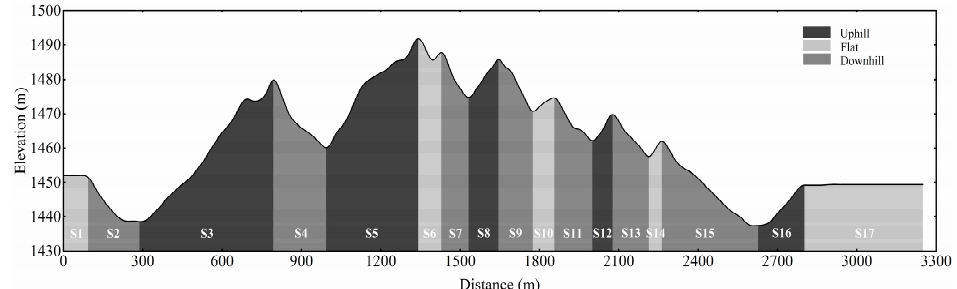
Figure 1. Course and elevation profile of the 3.3 km racecourse used in the skating time-trial competition, including different sections of terrain.